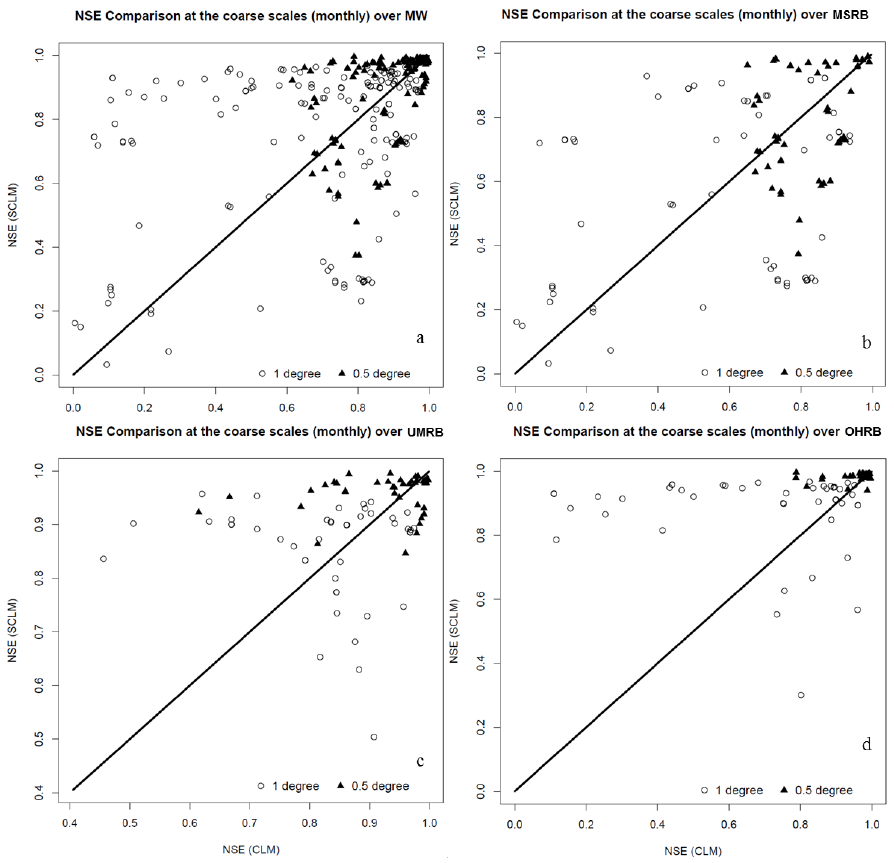
Figure 11. NSE values from monthly streamflow compared at the USGS stations with contributing area larger than 15000km 2 located in the whole Midwest (a) , and Missouri (b) , Upper Mississippi (c) and Ohio (d) regions.